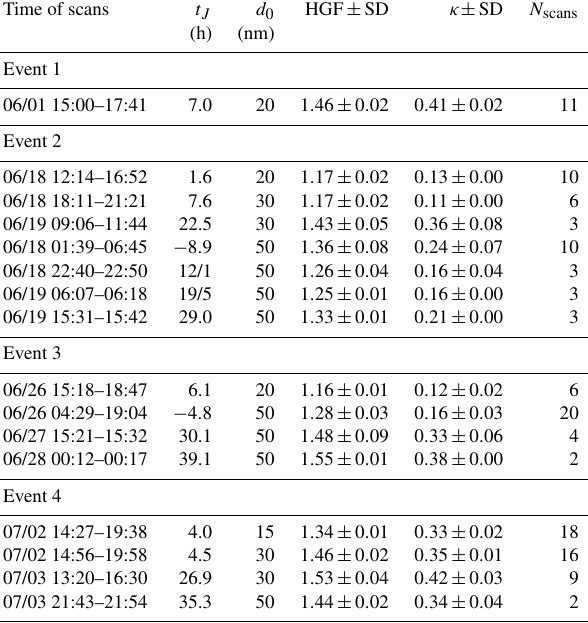
Table 2. Hygroscopic growth factor (at 90% RH) and hygroscop- icity parameter κ during NPF events. Here: time of scans – a time window during which hygroscopicity distributions were measured; t J – approx. time between the observed formation rate maximum and the measurements of HGF. In other words, t J indicates how long before/after the NPF events the HGF was measured. For ex- ample, if t J = 7, the HGF was measured 7h after the maximum in J . Negative t J indicates the measurements of HGF prior NPF event; d 0 – selected diameter of dry particles; N scans – number of scans; SD – standard deviation. Date format: